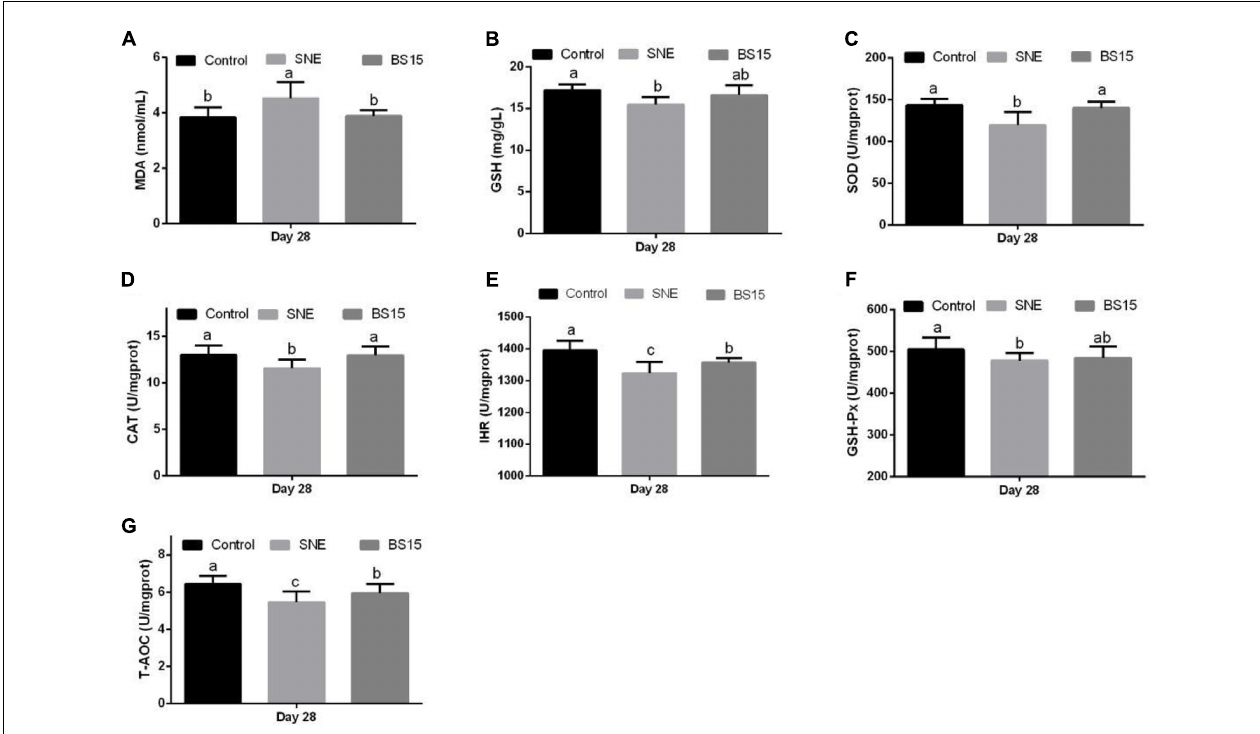
FIGURE 3 | Changes of MDA (A) , GSH (B) , SOD (C) , CAT (D) , IHR (E) , GSH-Px (F) , and T-AOC (G) in the serum at days 28 in Experiment 2. Bars with different letters are significantly different on the basis of Duncan’s multiple range tests ( P < 0.05). Data are presented as mean ± standard deviation (six replicates of one chick per cage). T-AOC, total antioxidation capacity; CAT, catalase; SOD, superoxide dismutase; GSH-Px, glutathione peroxidase; IHR, inhibiting hydroxy radical; MDA, malondialdehyde; GSH,